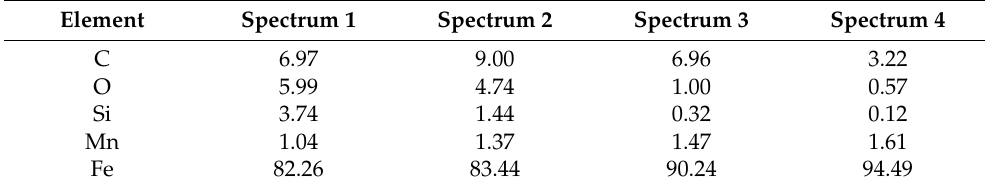
Table 4. Element content (%) of spectrums 1–4, as measured via EDS.